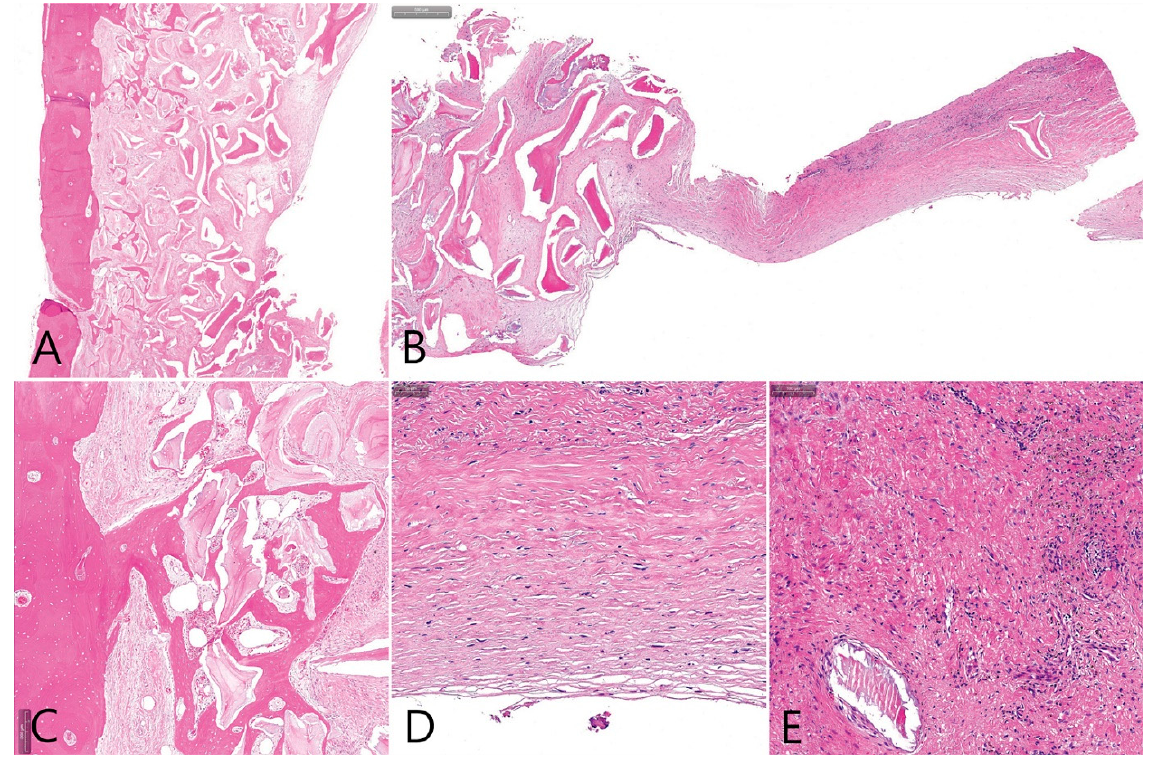
Figure 6. ( A ) Histopathological findings of the removed specimen (H-E stain). On the left side of the specimen is the cortical layer of the lateral bone window. To the right of the bone is the maxillary sinus bone graft. The empty space on the far right is the grafting void; ( B ) soft tissue surrounding the grafting void connected to the bone graft was observed; ( C ) new bone formation was observed in the area adjacent to the lateral window; ( D ) the soft tissue surrounding the grafting void was dense connective tissue, and no epithelial cells were observed; ( E ) a large number of fibroblasts were distributed in the dense connective tissue, and no inflammatory cells were observed.